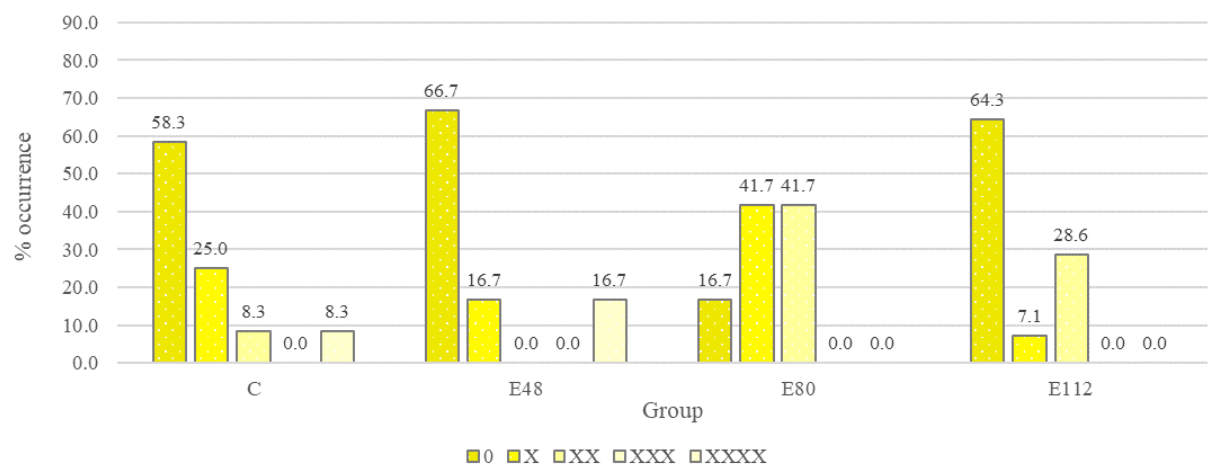
Figure 7. Distribution of levels of positive samples by level of occurrence at the end of the experiment ( n = 10–14).